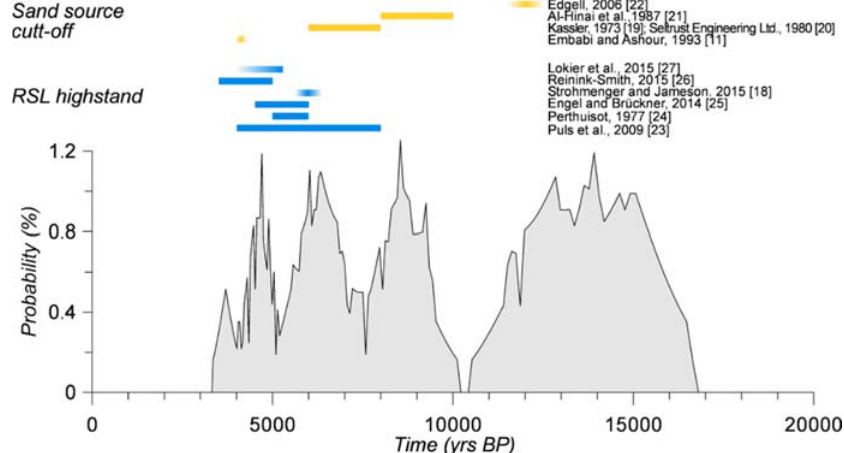
Figure 9. Probability density function of travel times of the 15 barchan dunes (width 100–500 m) of SE Qatar in closest proximity to the NW coast (Figure 1a). Data are displayed in combination with chronological estimates of the relative sea-level (RSL) highstand (blue bars) and the loss of the sand source (yellow bars) as inferred from literature.